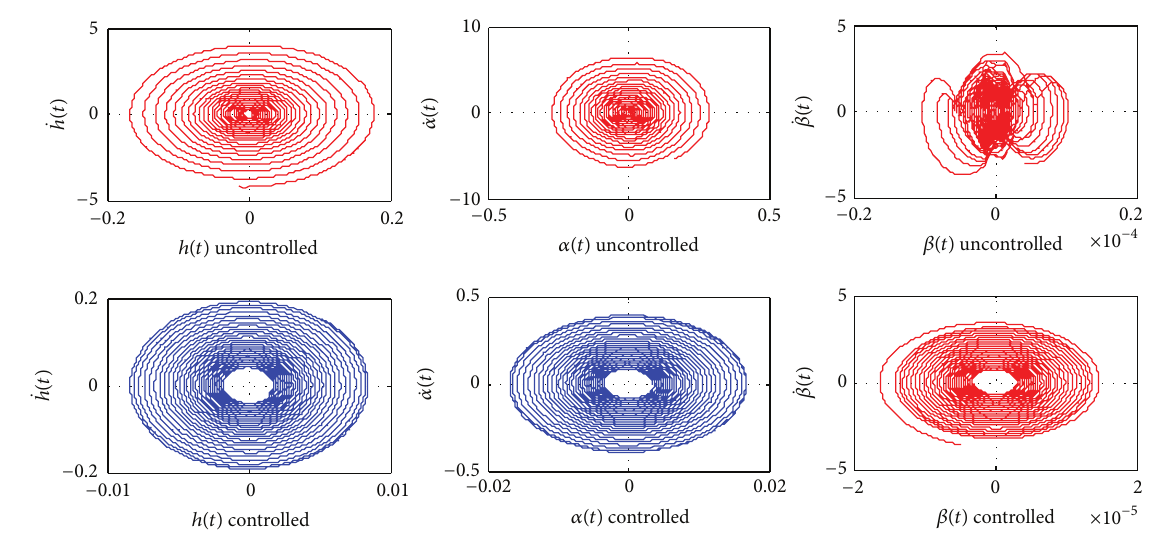
Figure 19: Case 2: phase plan ( |𝛿| = 0.6 ∘ and 𝑉 = 13.1